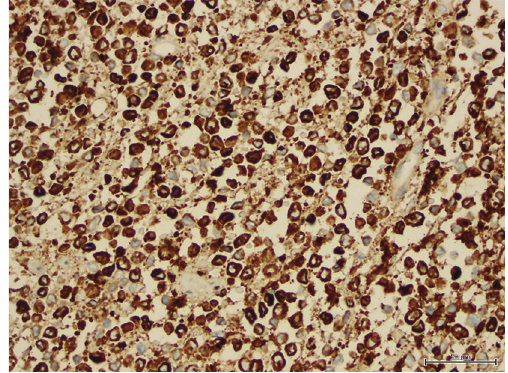
Figure 6: Neoplastic cells showing myeloperoxidase reactivity.